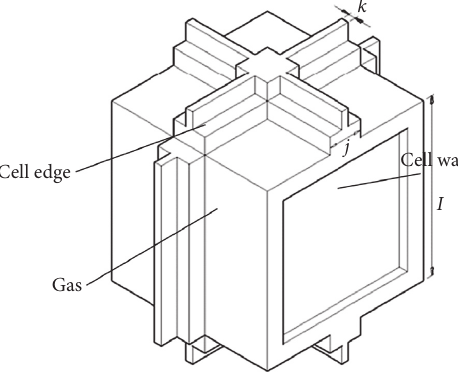
Figure 12: A single closed